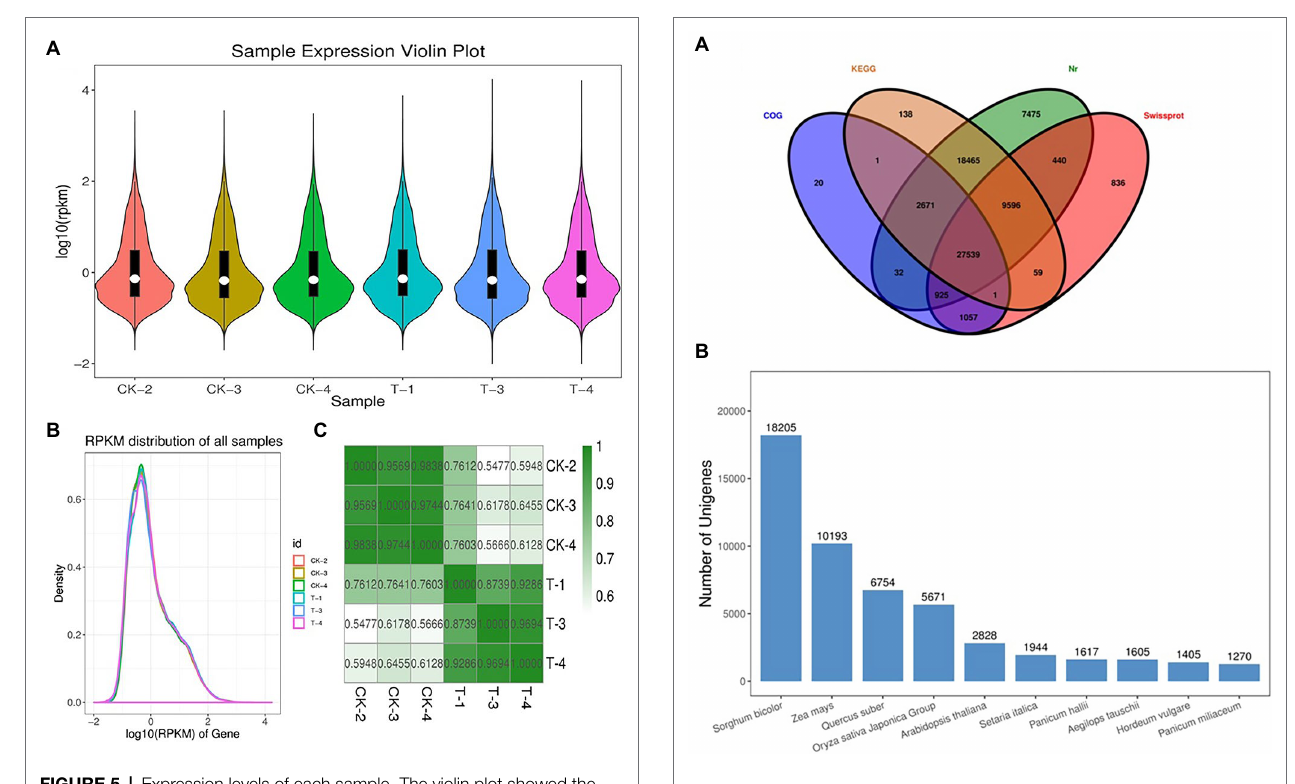
FIGURE 6 | Venn diagram annotated of the four major databases (A) , species distribution of the top BLAST hits against the NR database (B)